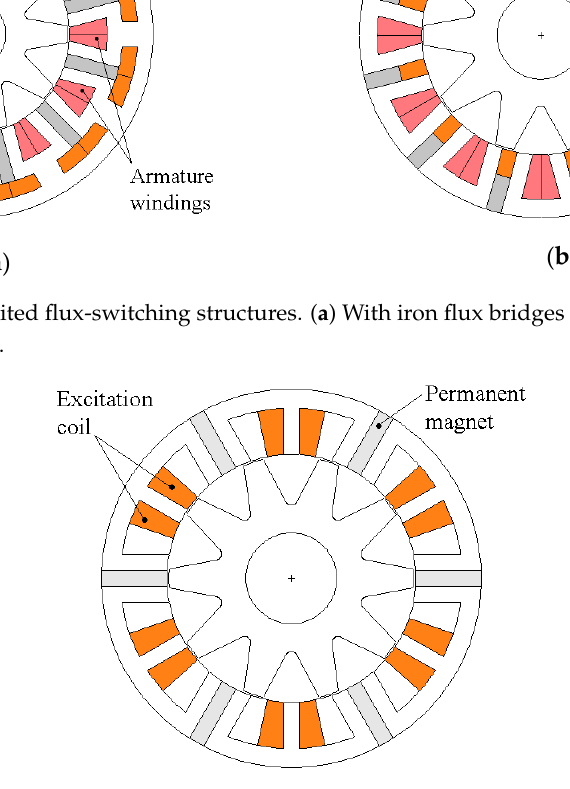
Figure 2. E-core hybrid excited flux-switching structure [16].